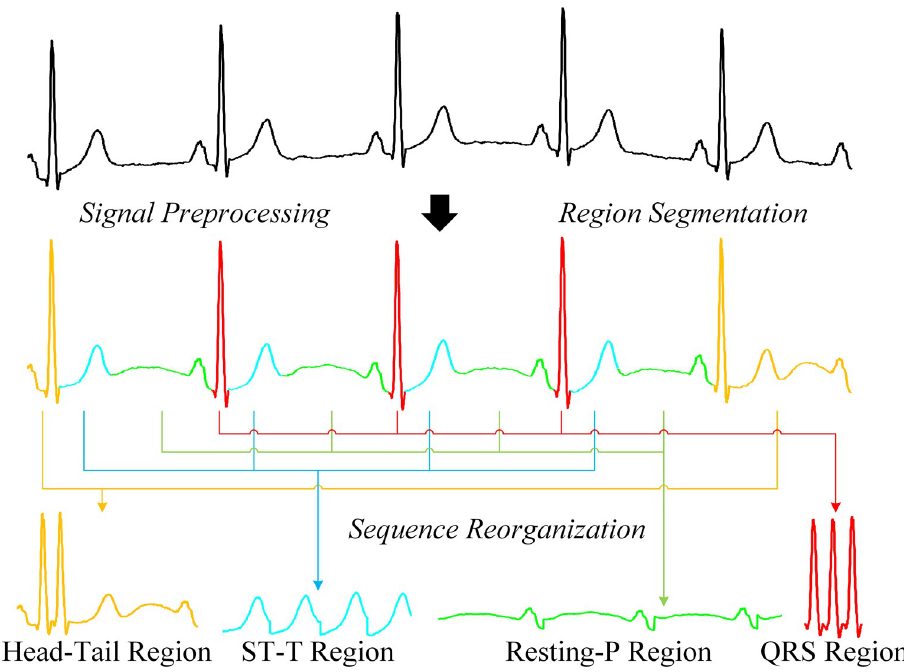
Fig 3. Result pattern of the ECG